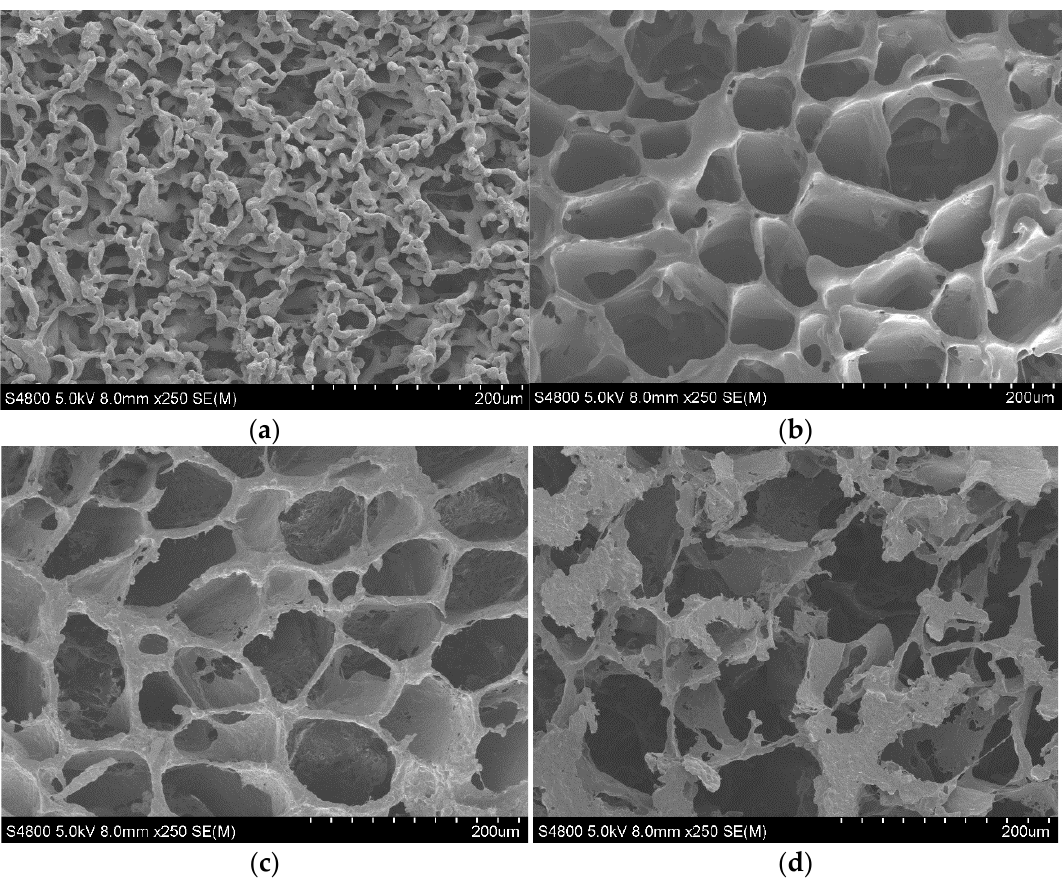
Figure 2. Representative SEM images of the surface morphology of PLCL composites. ( a ) PLCL × 250. ( b ) PLCL/rGO 0.3wt% × 250. ( c ) PLCL/rGO 0.6 wt% × 250. ( d ) PLCL/rGO 1wt% × 250.